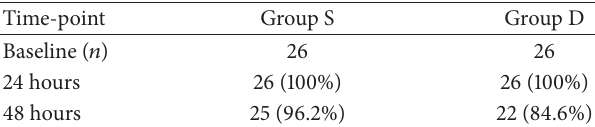
Table 1: The number of patients with data collected during each day of the trial.